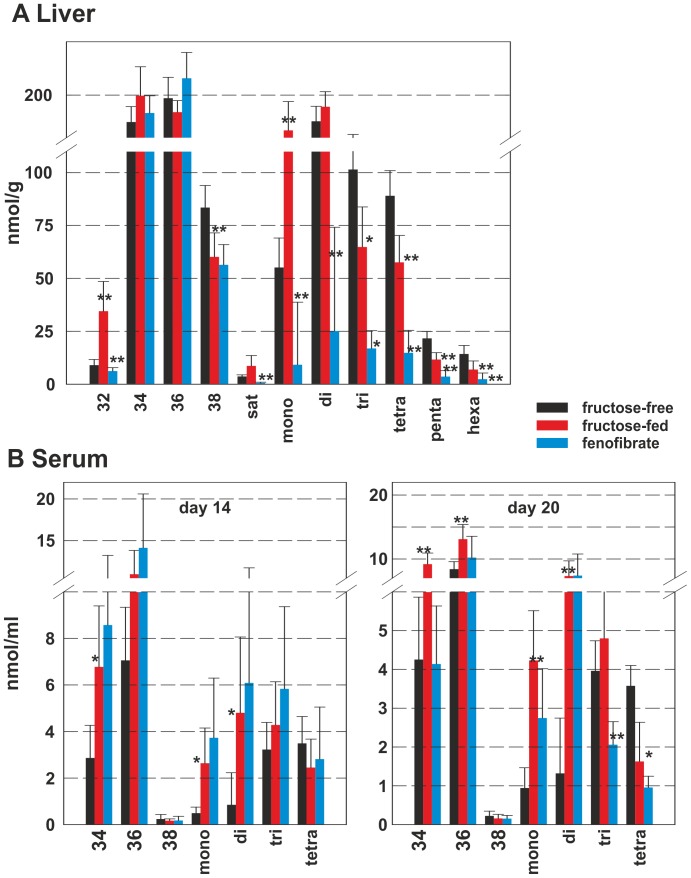
DAG-species in rat liver and serum.DAG-species in A rat liver and B rat serum. Values given are means±s.d. of the sums of the different chain lengths (C32 – C38) on the left and degree of desaturation (sat – hexa) on the right. Serum data is shown for day 14 and day 20; the control group is shown as black bar, the fructose-fed group is shown as red bar and the FF treated group is shown as a blue bar; significant changes are indicated using *: P<0.05; **: P<0.01; ***: P<0,001.